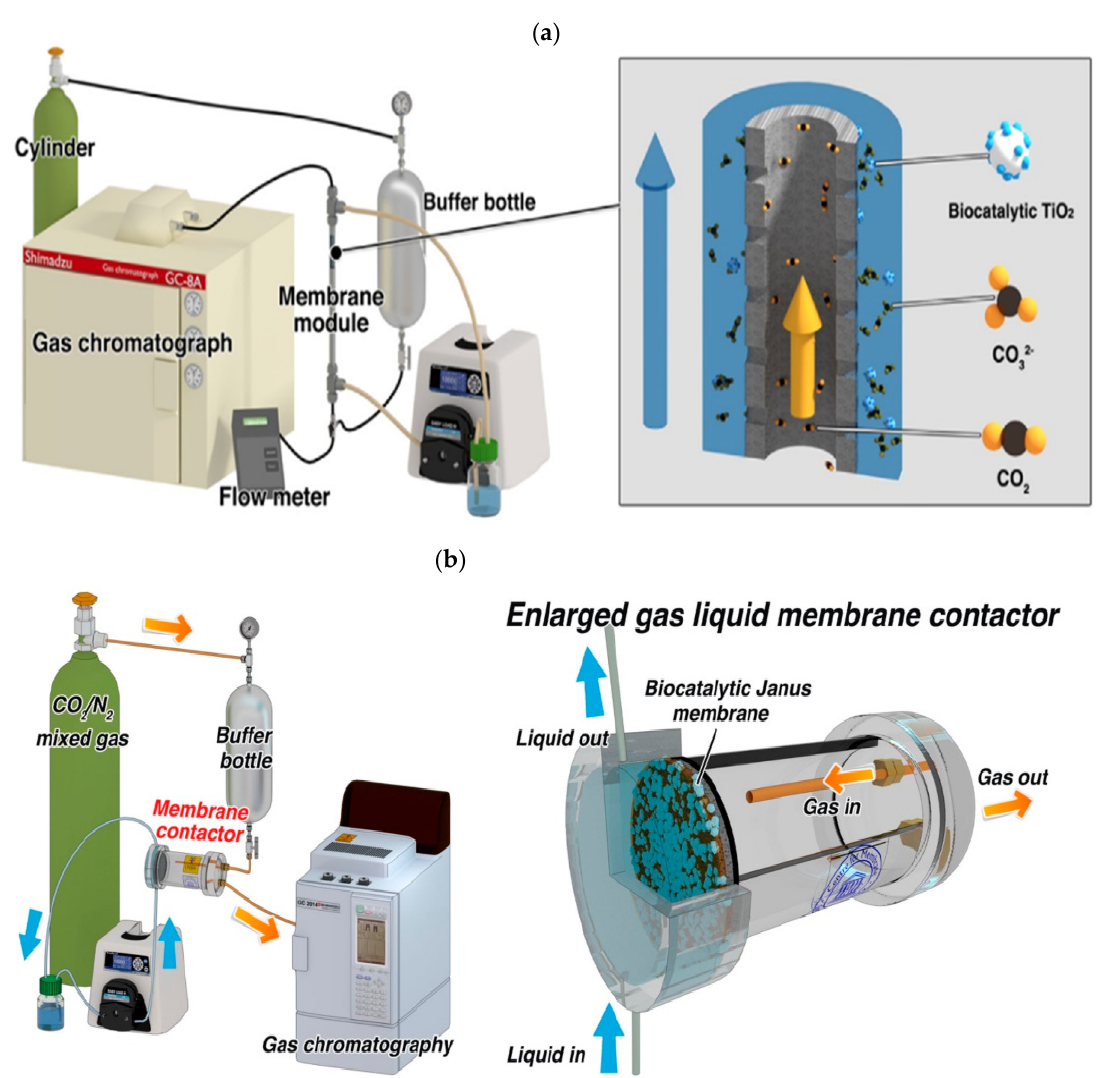
Figure 2. Schematic diagram of ( a ) the hollow fiber [36] and ( b ) flat-sheet Janus gas–liquid membranes contactors (GLMCs) [39] incorporated with encapsulated CA in TiO 2 nanoparticles applied to catalyze CO 2 hydration.